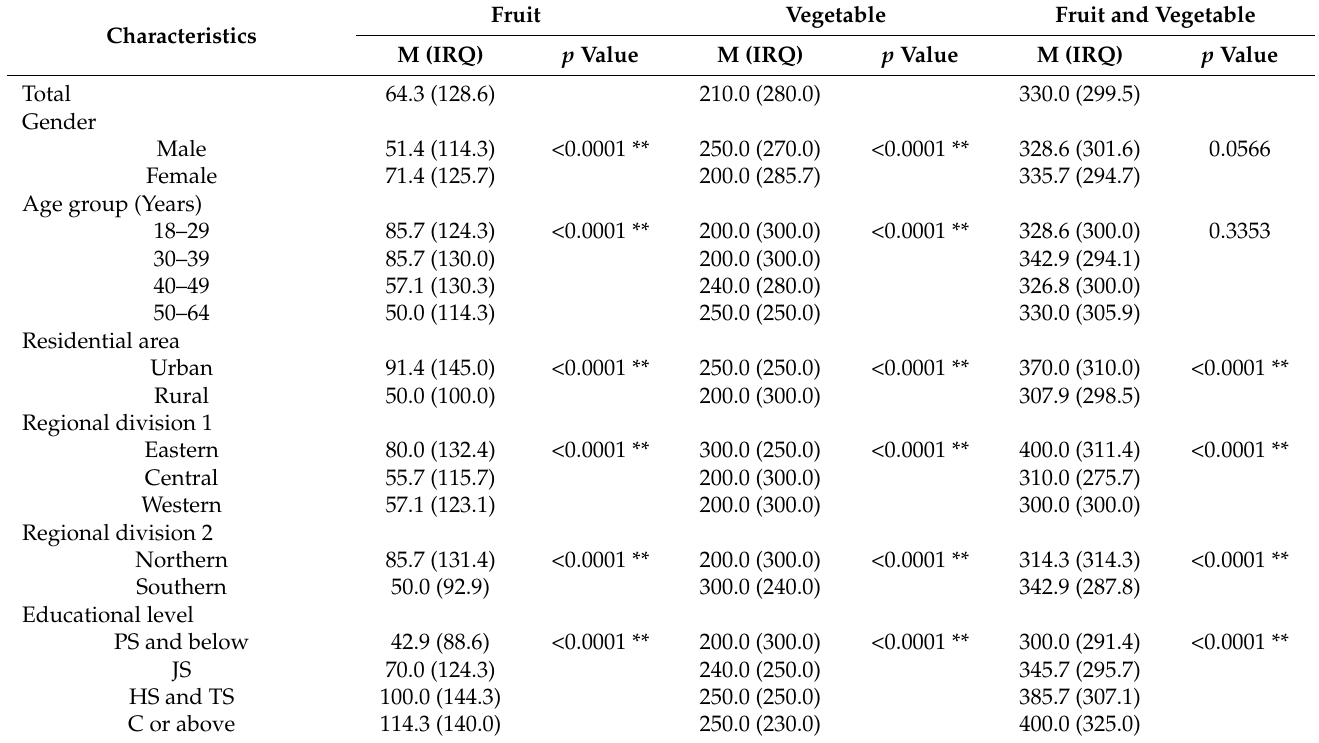
Table 2. Daily consumption of fruit and vegetables of labor force in China, 2015